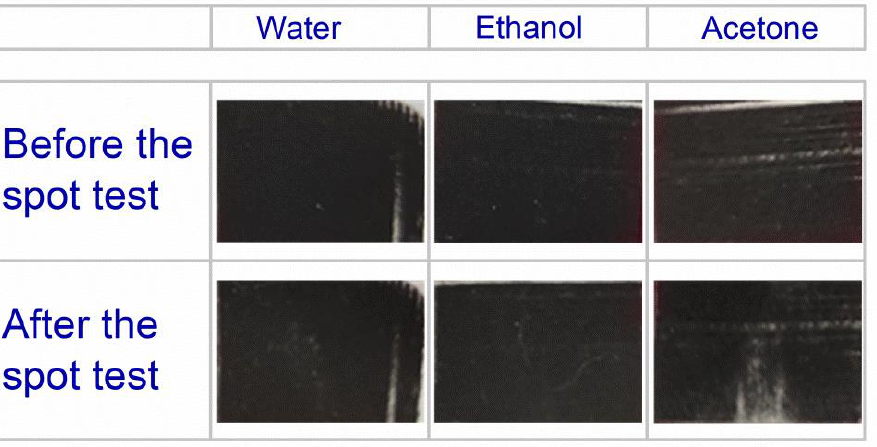
Figure 10. Stability test on printed specimens with different solvents.